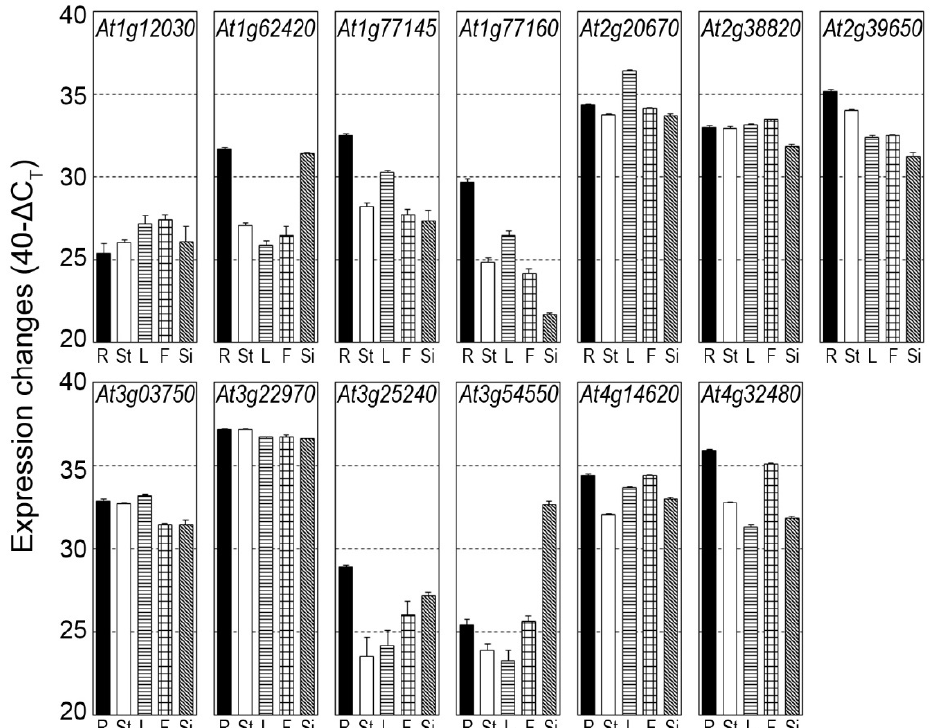
Figure 5. Expression profile of Arabidopsis DUF506 genes in different tissues. R, root; St, stem; L, leave; F, flower; Si, silique. Changes of gene expression level between tissues are interpreted as described in [31]. Expression levels are given on a log scale expressed as 40 − ∆ CT , where ∆ CT is the difference in qRT-PCR threshold cycle number between the respective gene and the reference gene ( GAPDH ); 40 therefore equals the expression level of GAPDH ; the number 40 was chosen because the PCR run stops after 40 cycles. The fold difference in expression is 2 ∆∆ CT when PCR efficiency is 2 (e.g., an ordinate value of 34 represents 16-fold lower expression than a value of 38).